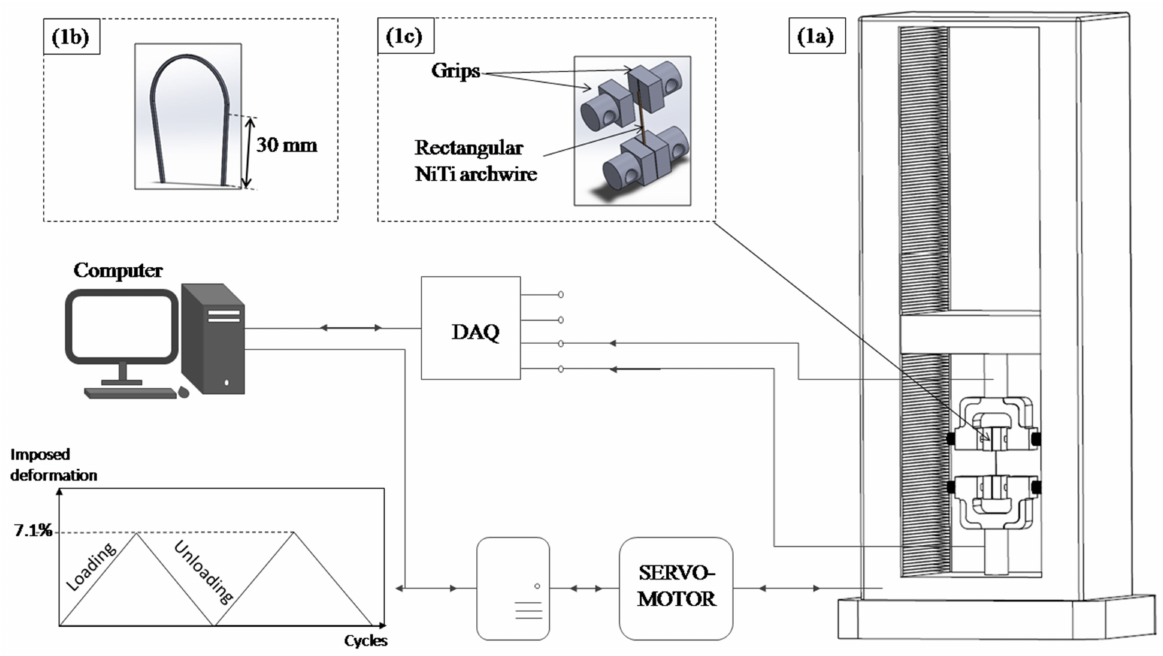
Figure 1. Loading protocol of the monotonic and cyclic loading: ( a ) Schematic representation of the Instron tensile machine, ( b ) used part of the as-received alloy, and ( c ) clamping method of the NiTi archwire.